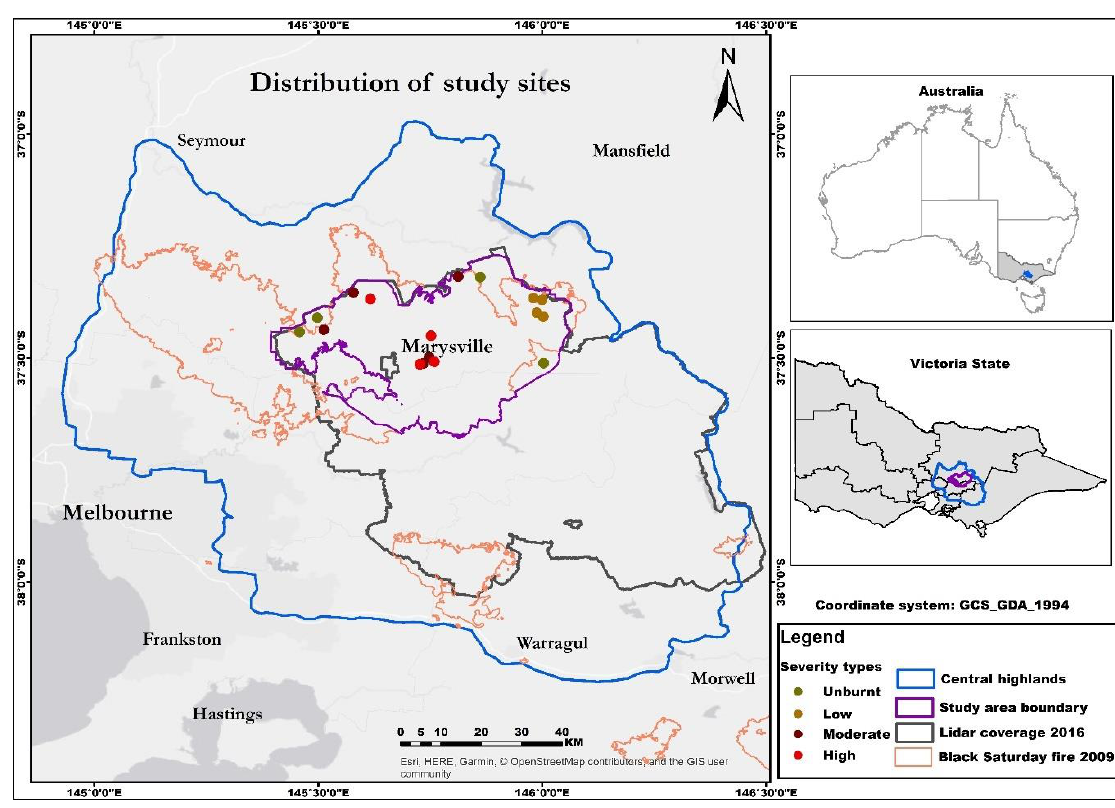
Figure 1. Location of the study sites (as coloured dots), extent of 2016 LiDAR data, and the study area (defined by the overlap of the 2009 wildfire, the LiDAR data, and the distribution of the herb-rich Foothill Forest).